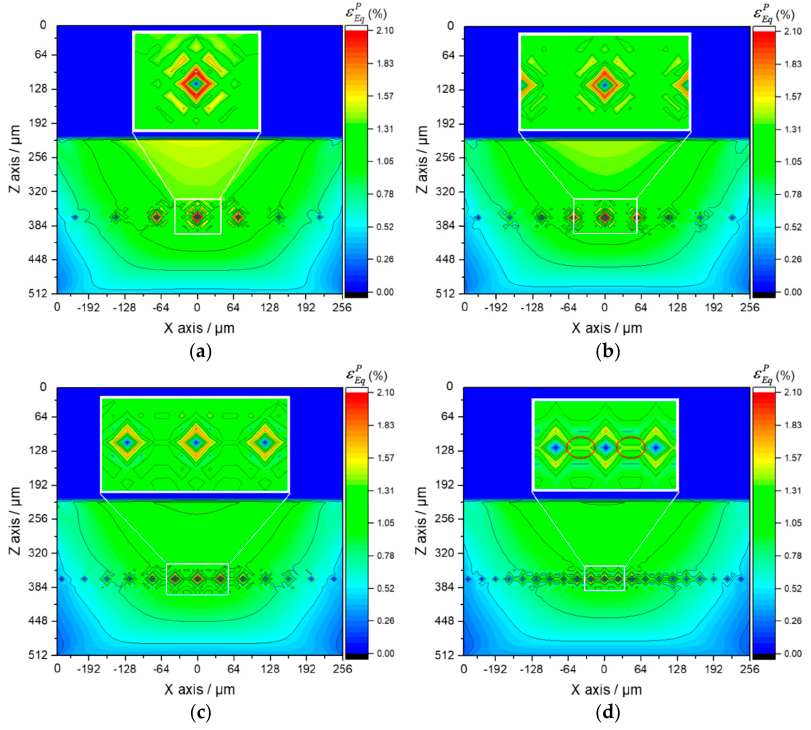
Figure 22. Equivalent plastic strain fields in cross section XOZ with varying ratios between center distance of adjacent SiC fibers d 0 and fiber diameter d f : ( a ) d 0 /d f = 8, ( b ) d 0 /d f = 6, ( c ) d 0 /d f = 4, ( d ) d 0 /d f = 2.